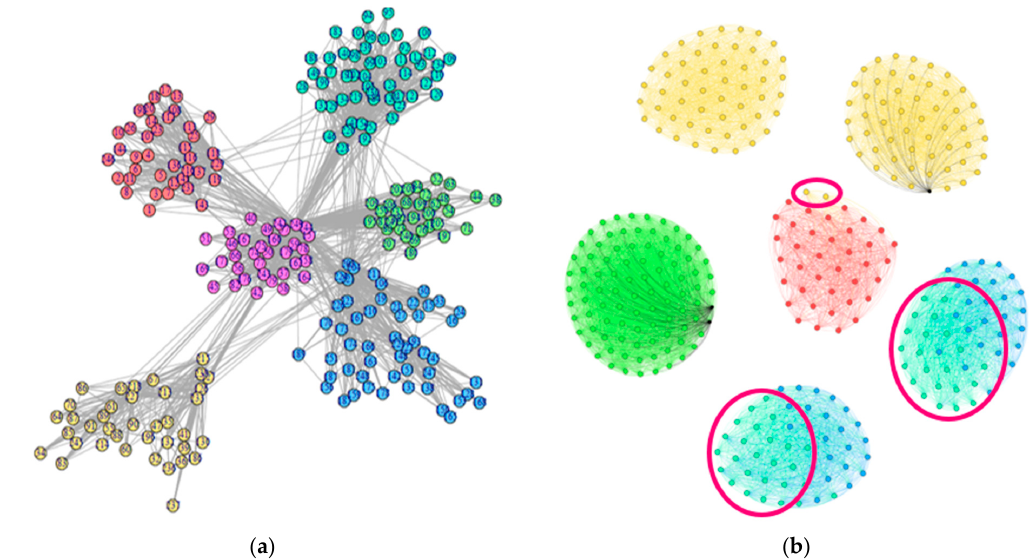
Figure 8. Telecom communities mapped over the G3-PLC network topology ( a ) and over existing cartographic data related to the network’s electrical topology ( b ).